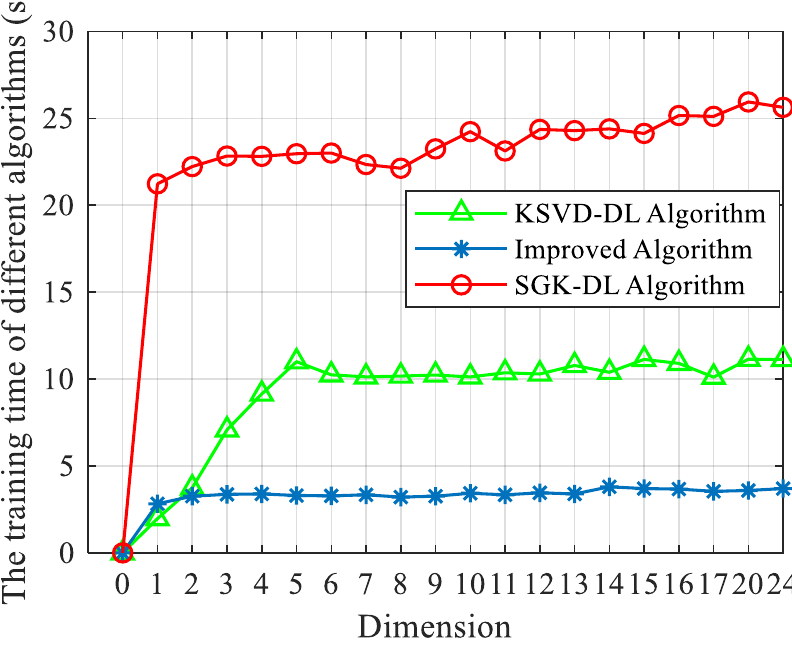
Figure 13. The recognition accuracy of the traditional algorithm and improved algorithm.